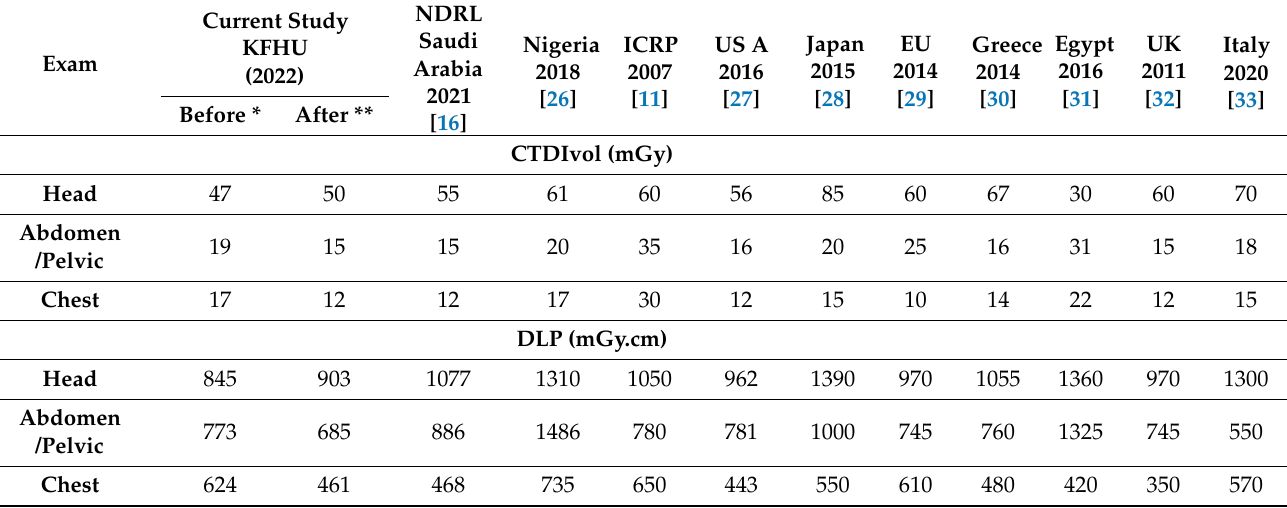
Table 2. Comparison between the current study results, National Diagnostic Reference Levels, and international studies.